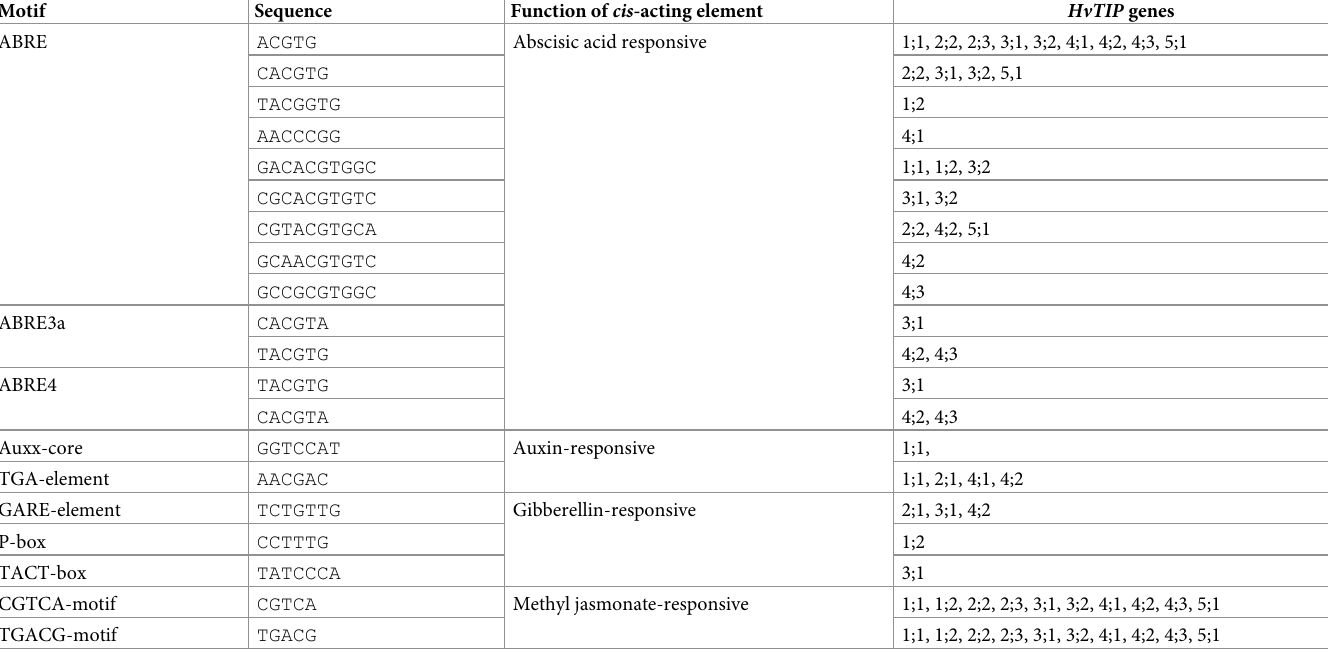
Table 3. Hormone-related cis -acting elements in the HvTIP